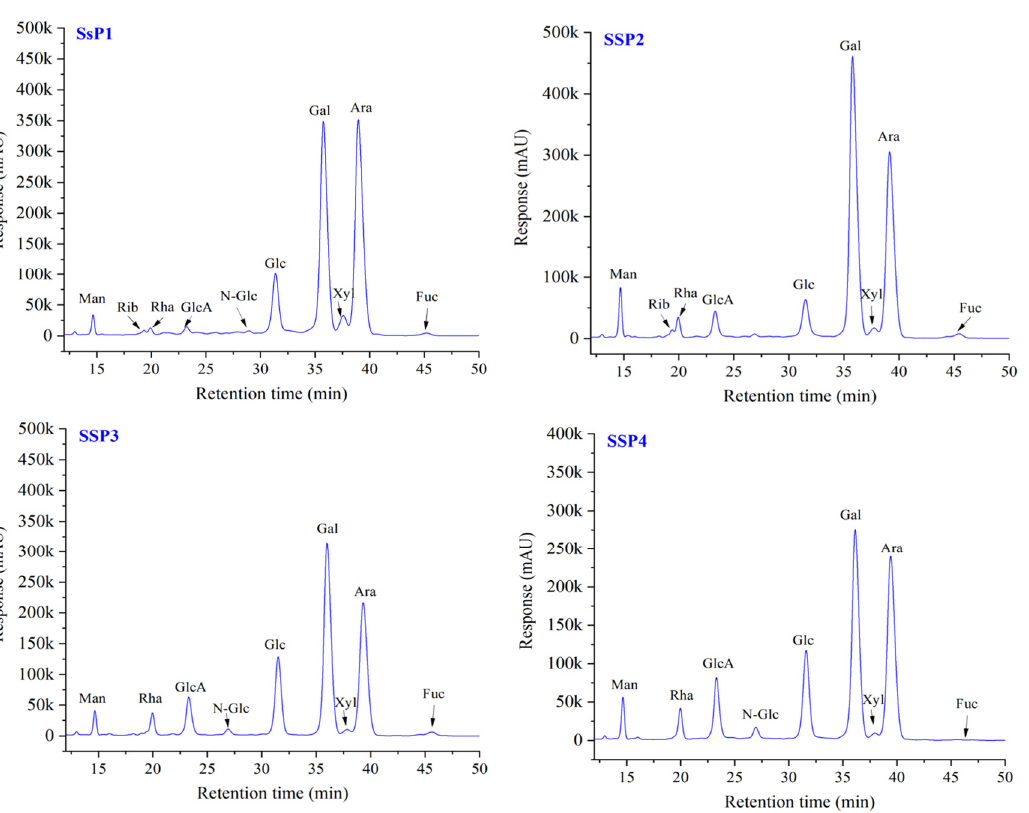
Figure 2. HPLC chromatograms of monosaccharides of SSPs. Abbreviations: Man, mannose; Rib, ribose; Rha, rhamnose; GluA, glucuronic acid; GalA, galactose acid; N-Glu, N-acetyl-amino glucose; Glu, glucose; N-Gal, N-acetyl-amino galactose; Gal, galactos; Xyl, xylose; Ara, arabinose; Fuc, fucose.